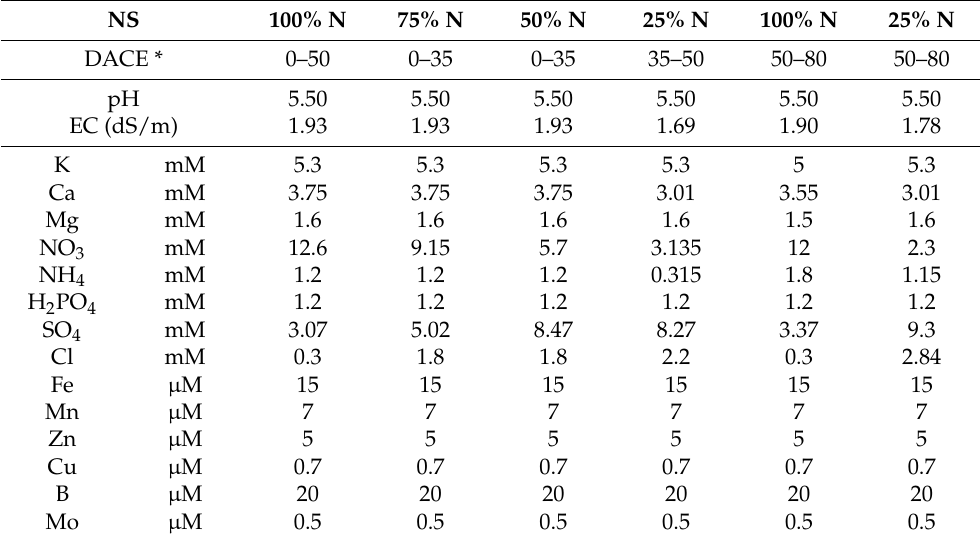
Table 5. Chemical composition of the applied